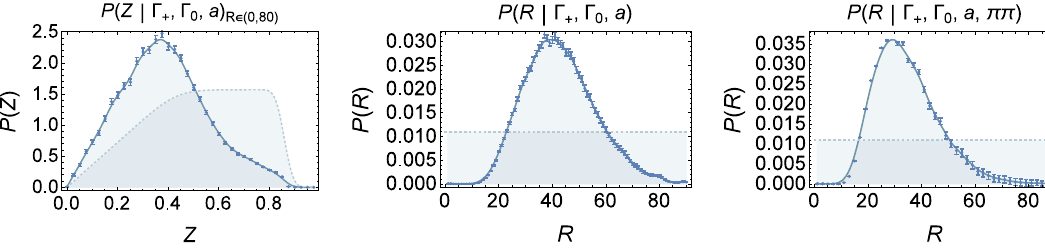
Fig. 7 Probability densities in comparison with the prior (transparent). R free, η → 3 π data (left, middle), η → 3 π and ππ scattering data (right). Smoothed. Error bars estimate the precision of the Monte Carlo